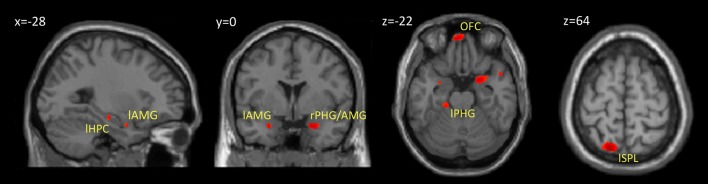
Brain regions showing a subsequent memory effect. The figure shows the results from contrast between subsequently recognized faces (hits) and subsequently forgotten faces (misses) (p < 0.001, uncorrected). Abbreviations are listed in Table 1.